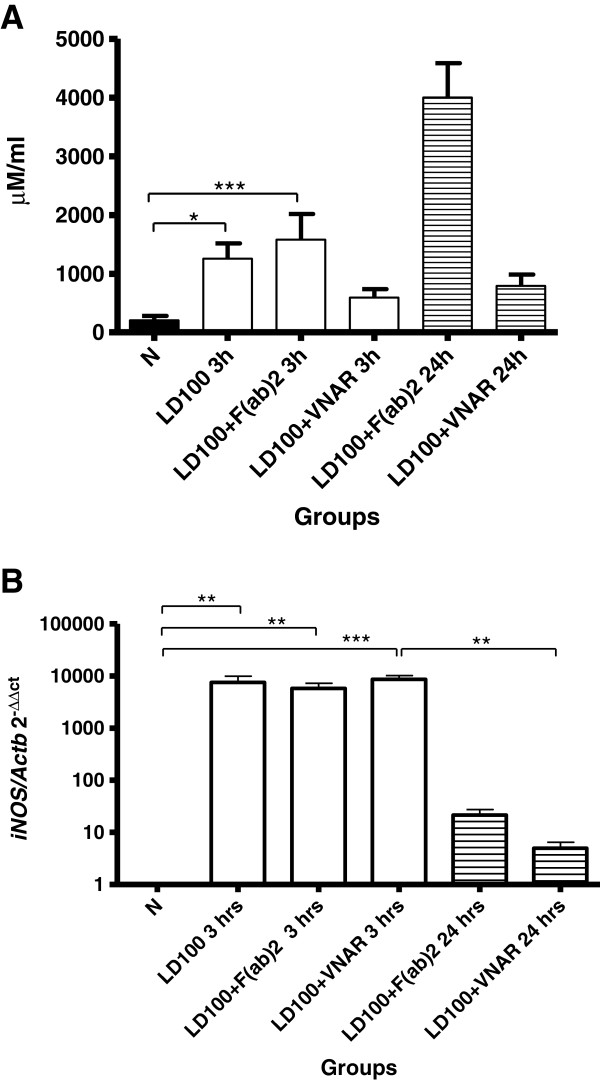
Production of NO2- and expression of iNOS. Panel A shows levels of NO2- in serum of groups LD100, LD100 + VNAR or LD100 + F(ab)2 at different times; panel B shows expression of iNOS in the same groups and times; data represent mean ± standard error. Differences among groups were determined using a Kruskal-Wallis test and post hoc using a Dunn’s multiple comparison test; differences were considered significant when *p < 0.05, **p < 0.01, **p < 0.001. N = 10 animals for each group and time point.